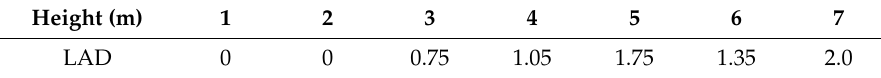
Table 2. The leaf area density (LAD) distribution of the ‘Bischofia Javanica’.